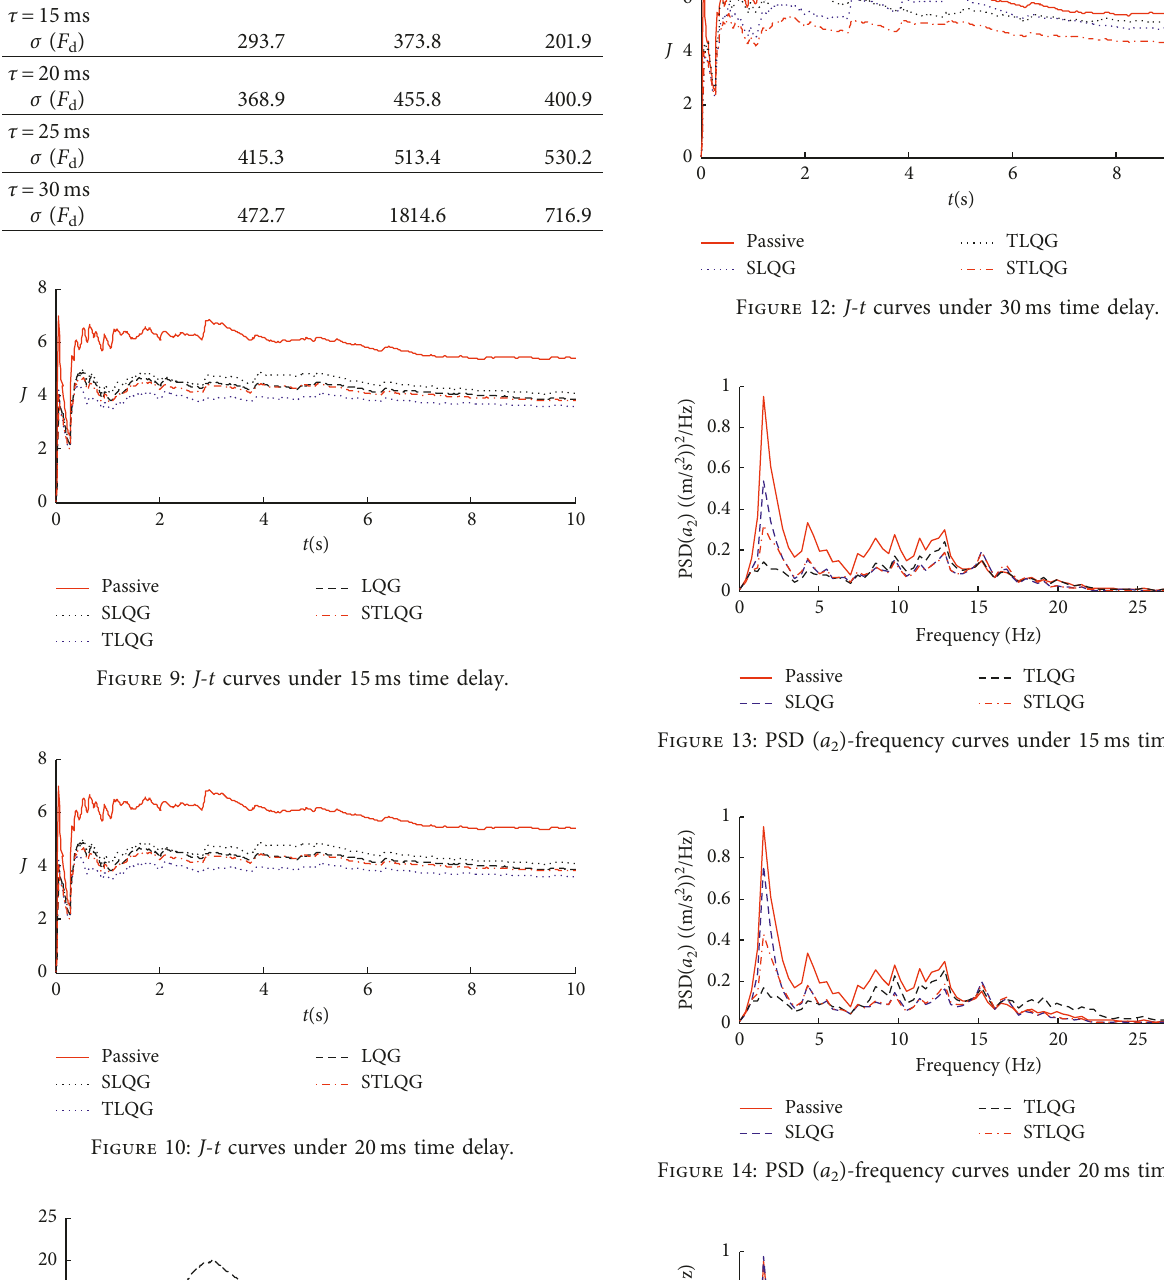
Table 2: Simulation results of the actual semiactive control force. Evaluator (N) STLQG SLQG